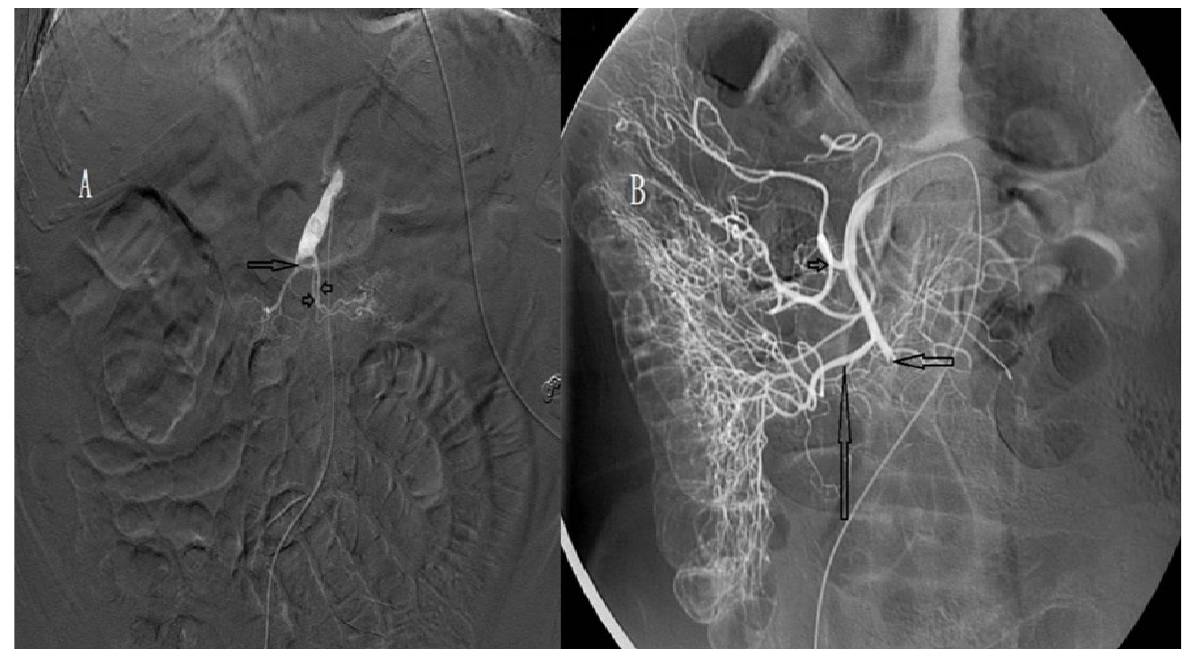
Figure 1. ( A ) Angiography of an 83 ‐ year ‐ old woman, showing complete occlusion (arrow) of the superior mesenteric artery (SMA) around the proximal jejunal arteries (arrowheads). Distal main trunk of the SMA is not visible. ( B ) Angiography of an 80 ‐ year ‐ old man, showing complete occlusion (short arrow) of the SMA. The middle colic artery (arrowhead) and right colic artery (long arrow) are visible.